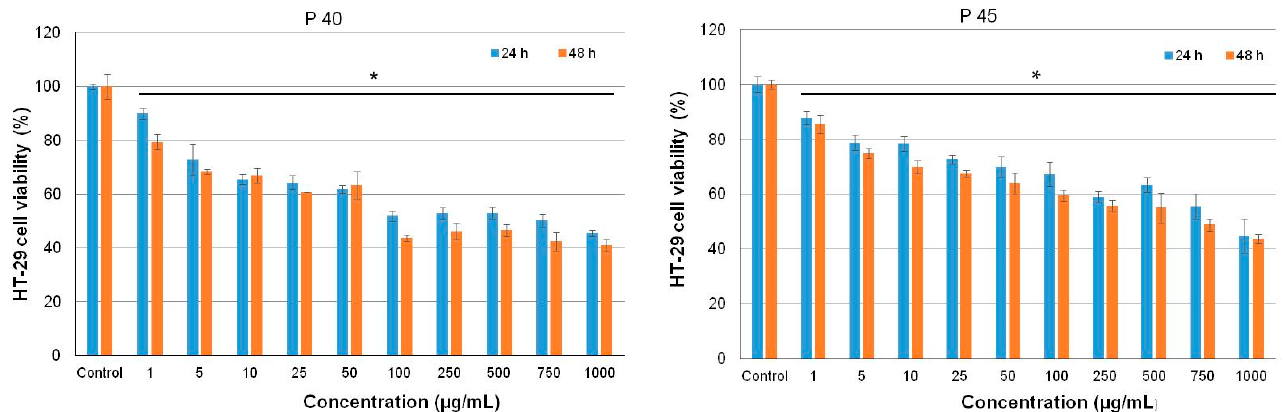
Figure 3. Cell viability of HT-29 cells cultivated in the presence of different concentrations of P40 and P45 microencapsulated samples, for 24 h and 48 h, assessed by NR assay. The results were expressed as mean ± SD ( n = 3). * p < 0.05, compared to untreated control.